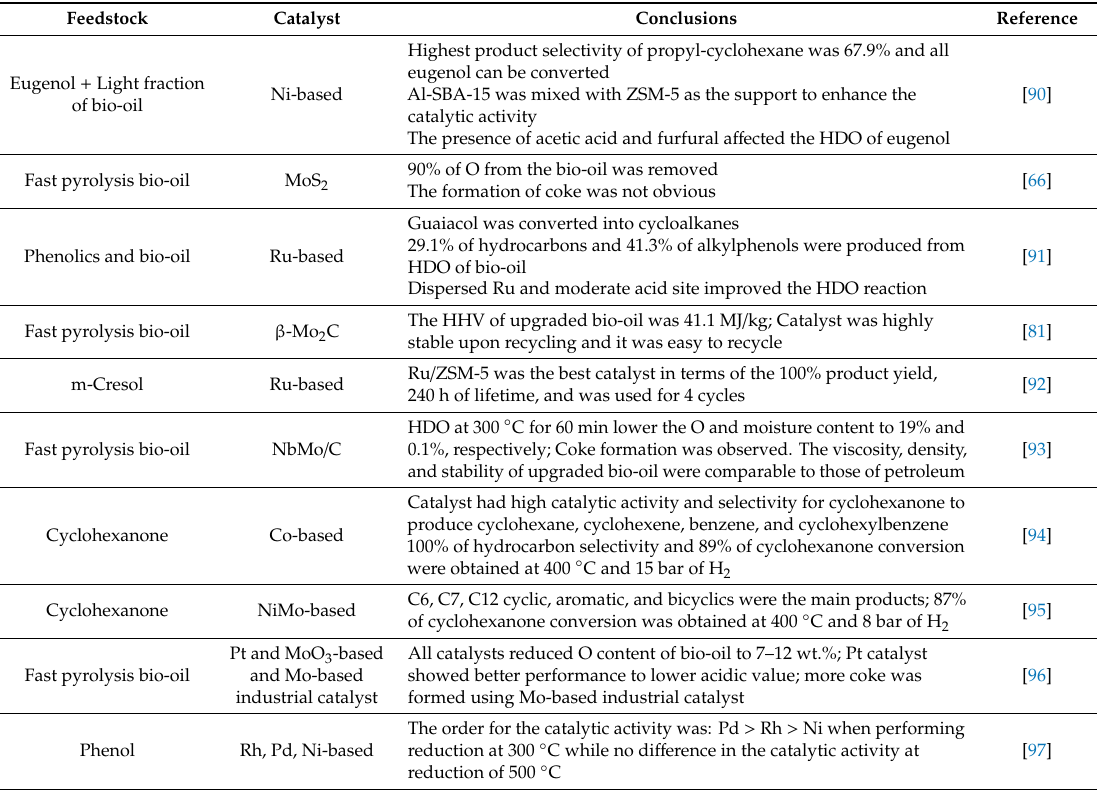
Table 7. HDO of different feedstocks and model compounds, including the applied catalyst. Table 7. HDO of di ff erent feedstocks and model compounds, including the applied catalyst.